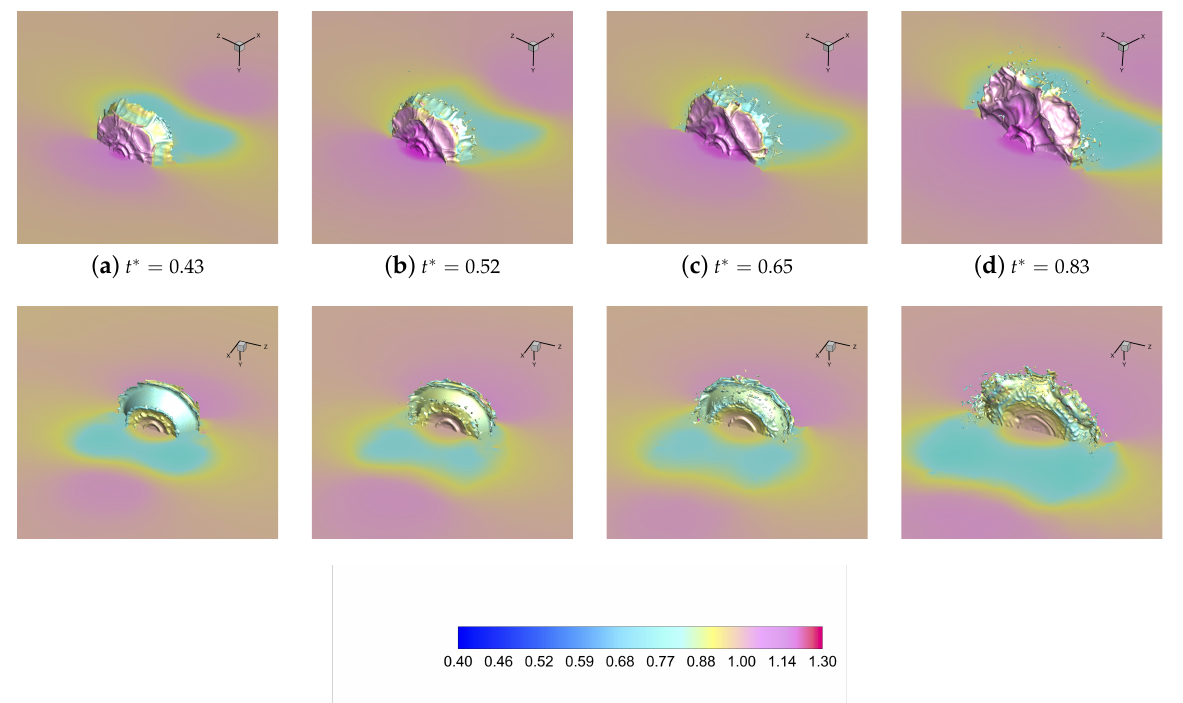
Figure 2. Normalized pressure contours depicted in the midplane y = 0, as well as on the droplet boundary, at four typical time instants with 0.43 ≤ t ∗ ≤ 0.83. Both front ( top ) and back ( bottom ) views are shown.